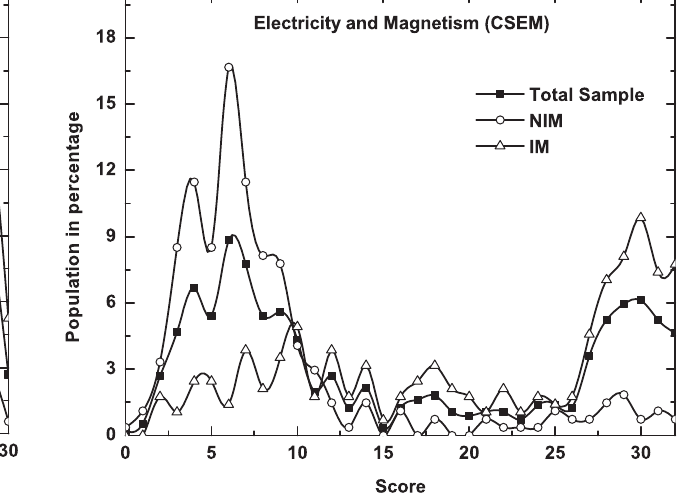
FIG. 2. Performance of Indian students in the CSEM [21], a standardized test in electricity and magnetism consisting of 32 questions. The graph is first plotted for the whole sample and then separately for the NIM and the IM. Note the bimodality in the plot for the whole sample.